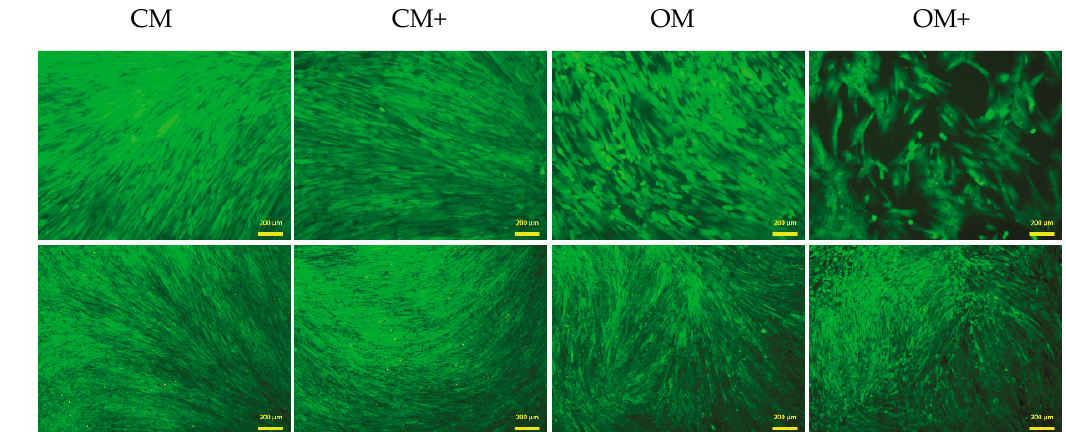
Figure 9. Live–dead assay of DPSCs. Cells were seeded onto 12-well plates and cultured with (CM+ and OM+) or without (CM and OM) BTCP-AE-FM samples for 7 and 14 days. After the incubation period, cells on the different surfaces were co-stained with fluorescein diacetate and propidium io- dide.